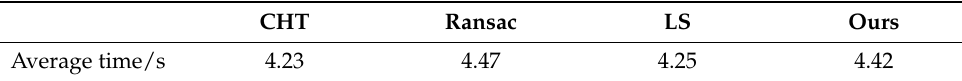
Figure 17. The measurement result of caps. Table 3. Comparison of measuring time of different